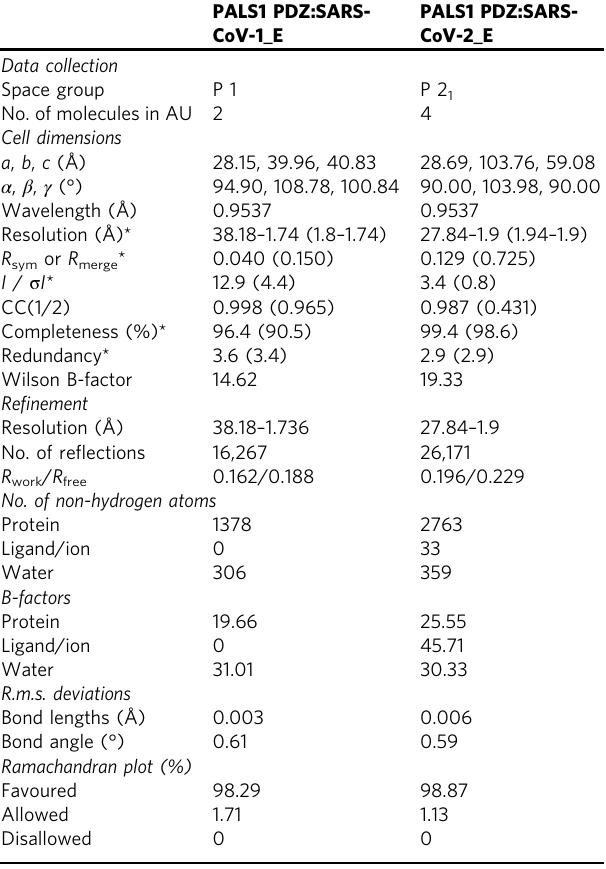
Table 2 X-ray data collection and re fi nement